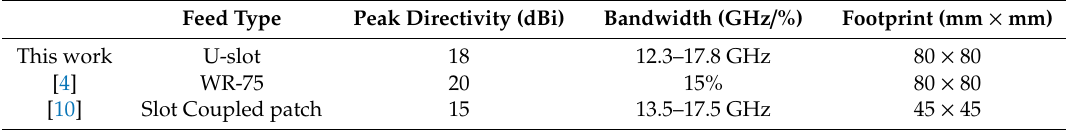
Table 3. Measured performance comparison of the proposed antenna with previously published